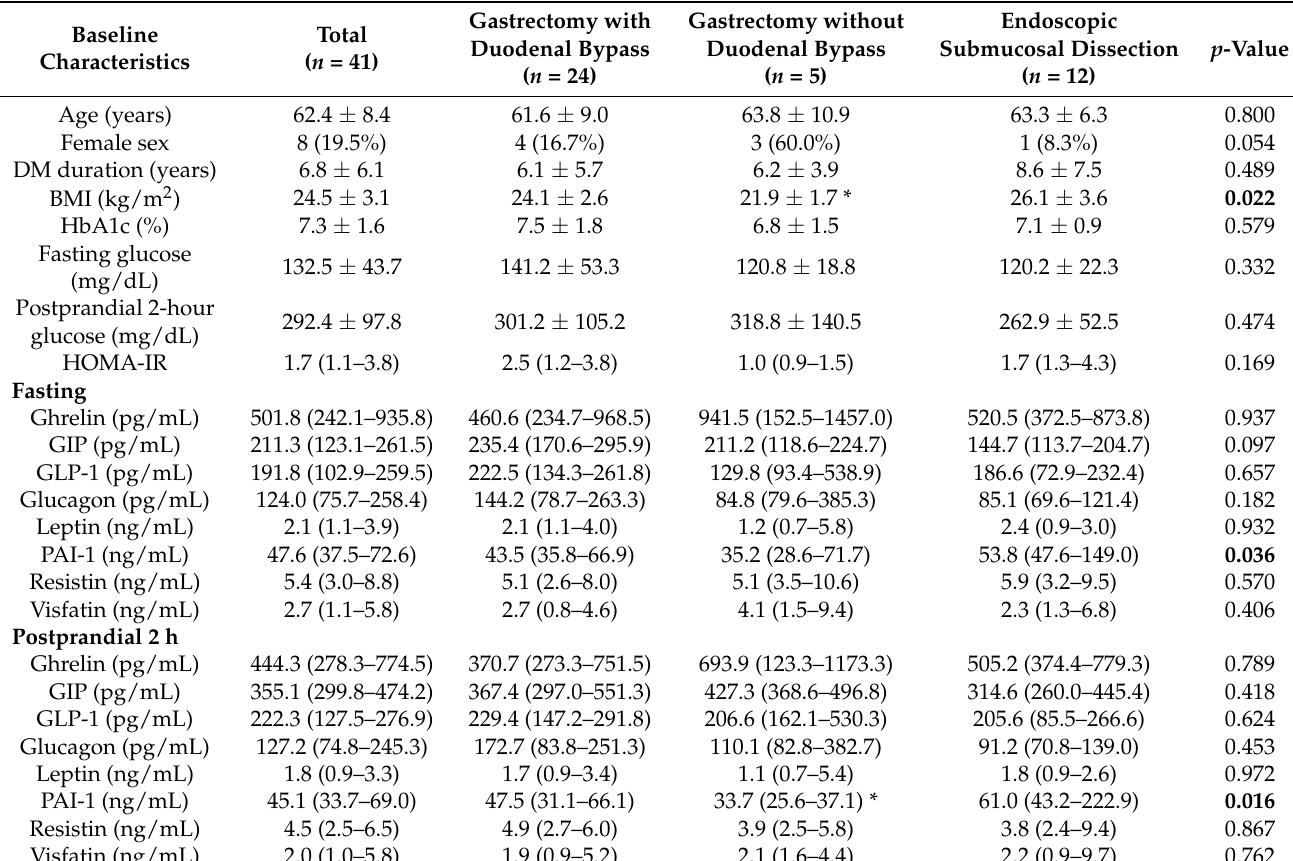
Table 1. Baseline characteristics of patients included in the analysis.